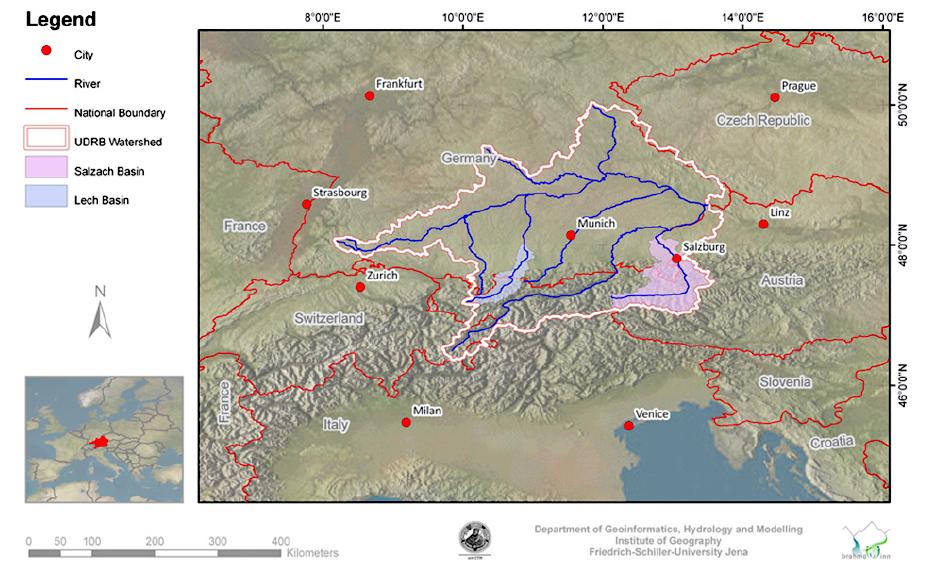
Figure 1. Upper Danube River Basin (UDRB) and its tributary countries in